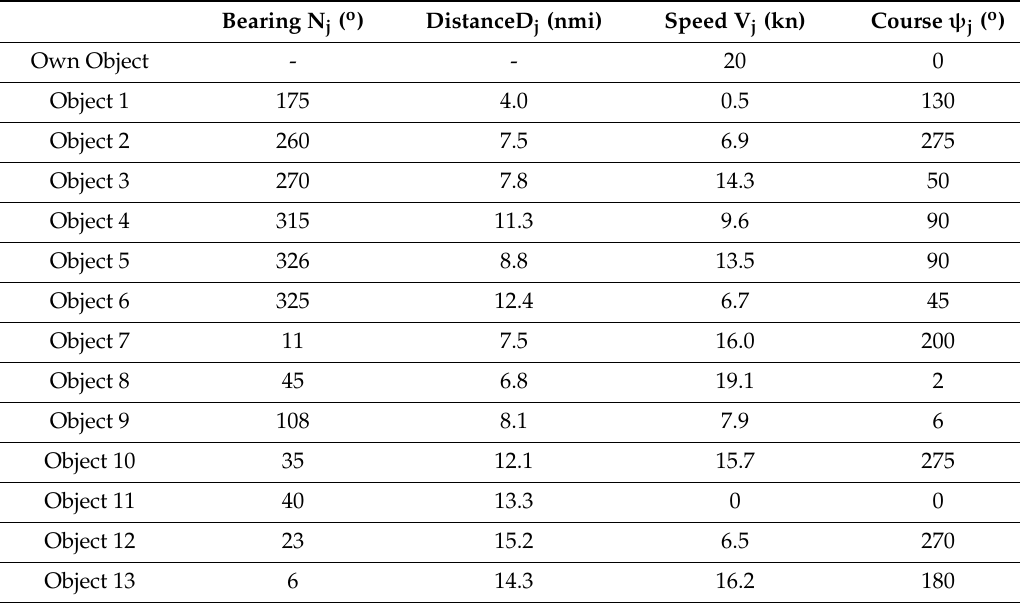
Table 2. Data of the own object and 13 encountered